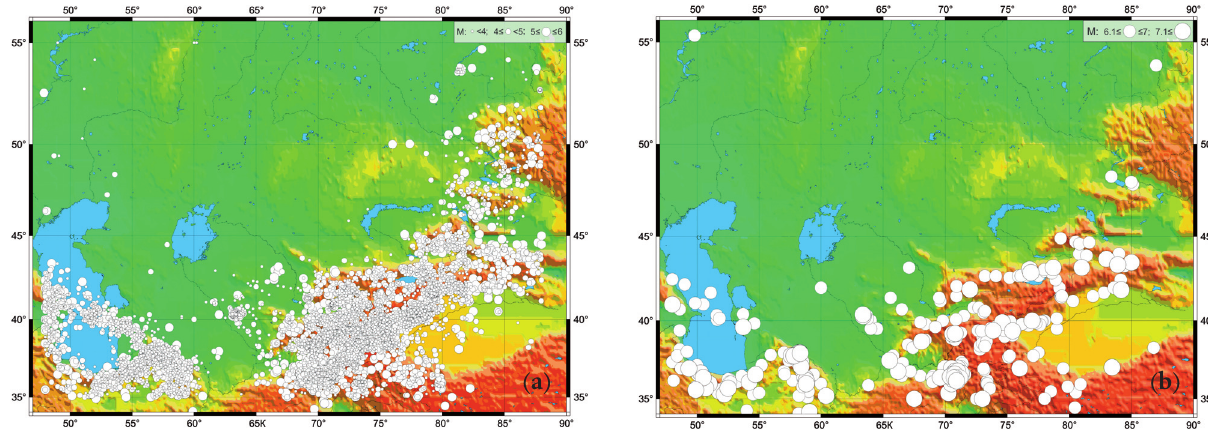
Figure 1. The map of earthquakes epicenters by the Central Asia catalogue EMCA until 1991. (a) with magnitude ≤ 6.0; (b) with magnitude ≥